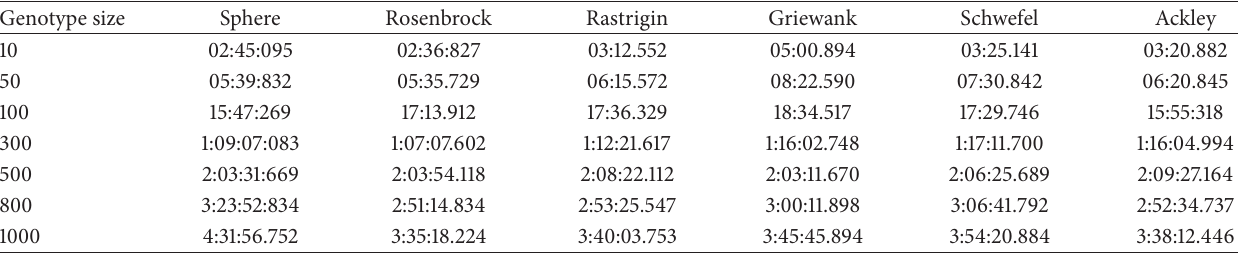
Table 5: CPU time results of the MBO algorithm for the genotype sizes of 10, 50, 100, 300, 500, 800, and 1000; number of runs = 1; iteration = 10000.